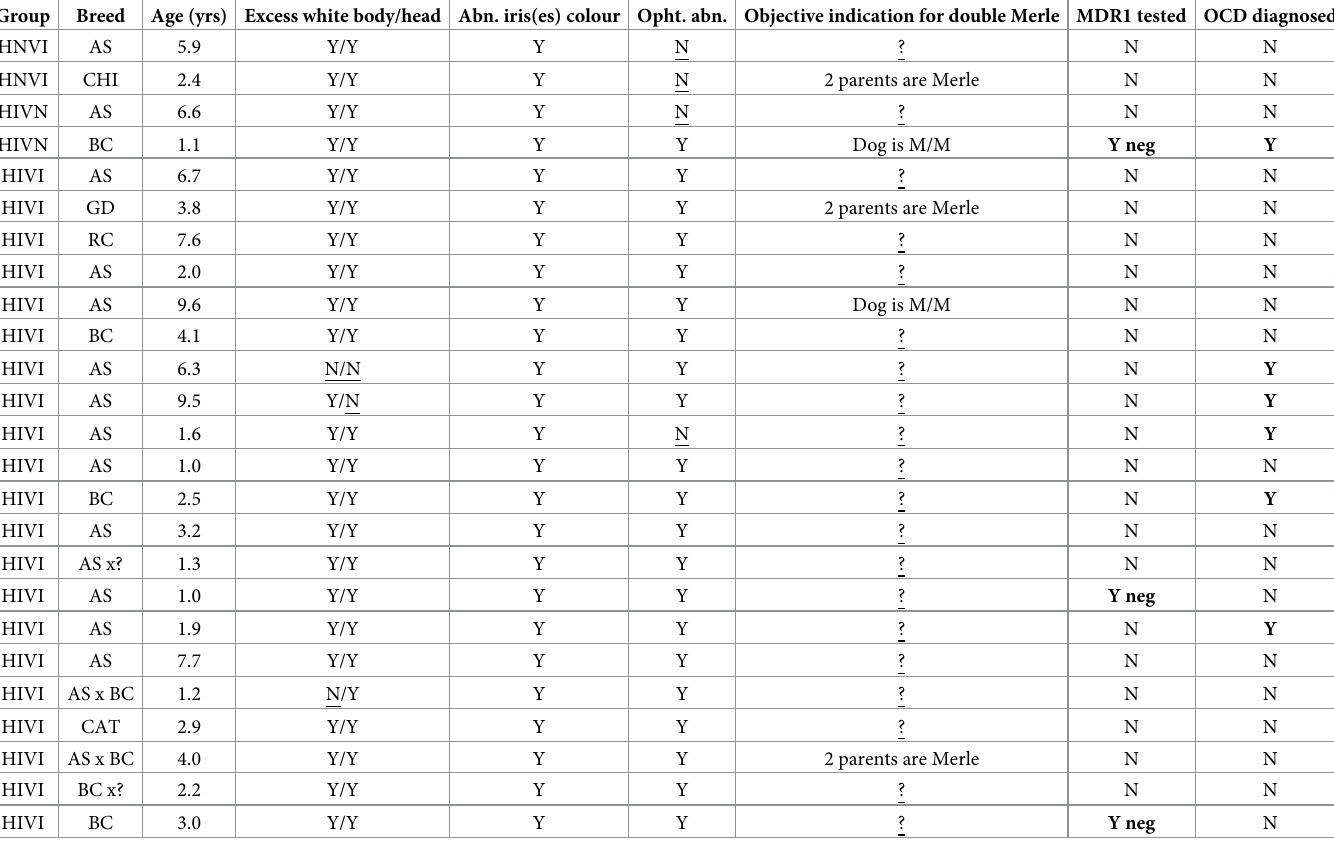
Table 6. Summary data for the 25 sensory impaired dogs for which neurological troubles were reported by their owners. Group